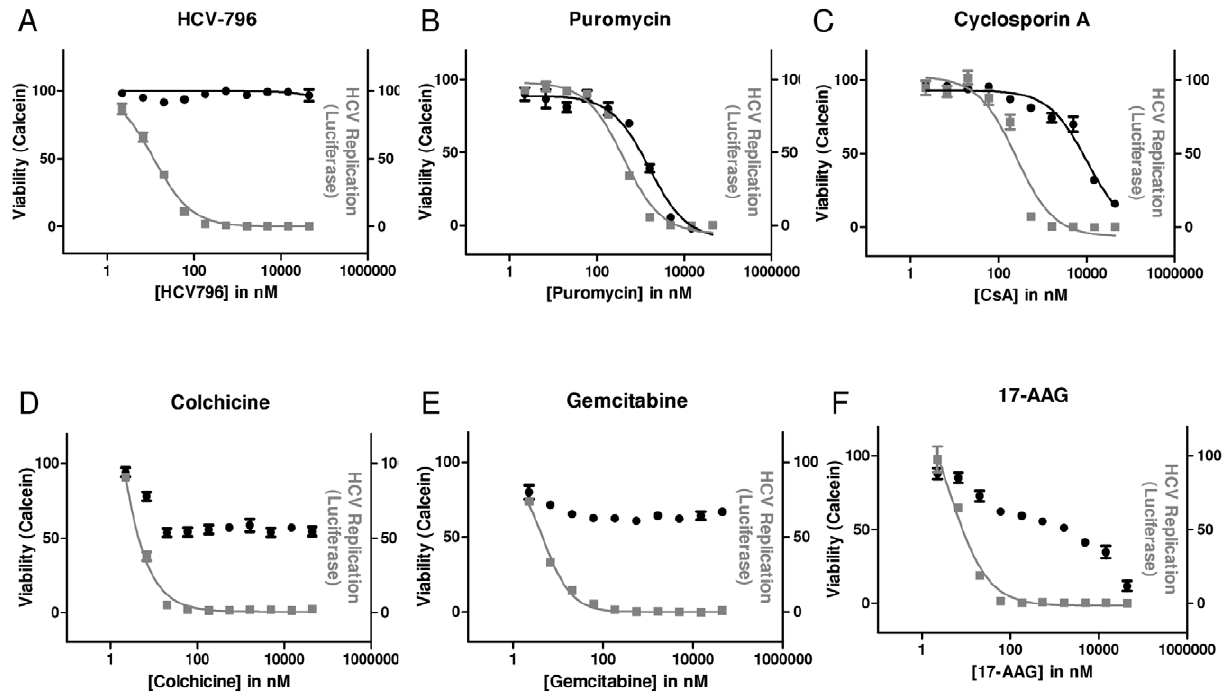
Figure 1. Effect of 17-AAG and CsA on HCV replication and viability determined by intracellular esterase activity. Antiviral activity (measured using the Renilla luciferase encoded by the HCV replicon; gray) and cell viability (measuring through the cleavage of calcein-AM by intracellular esterases; black) were assessed as a function of dose in a three day assay for the following molecules: (A) the HCV polymerase inhibitor HCV-796, (B) the ribosomal inhibitor puromycin, (C) the cyclophilin inhibitor CsA, (D) the microtubule inhibitor colchicine, (E) the anti-metabolite gemcitabine, and (F) the HSP90 inhibitor 17-AAG. doi:10.1371/journal.pone.0030286.g001 per image when compared to the no-drug control (Fig. 4D). In agreement with the intracellular ATP assay data, these data suggested that the antiviral effect of puromycin, gemcitabine, and 17-AAG was a consequence of adverse effects on cell health or proliferation. In contrast, CsA and HCV-796 display antiviral activity at concentrations that do not alter cell number.